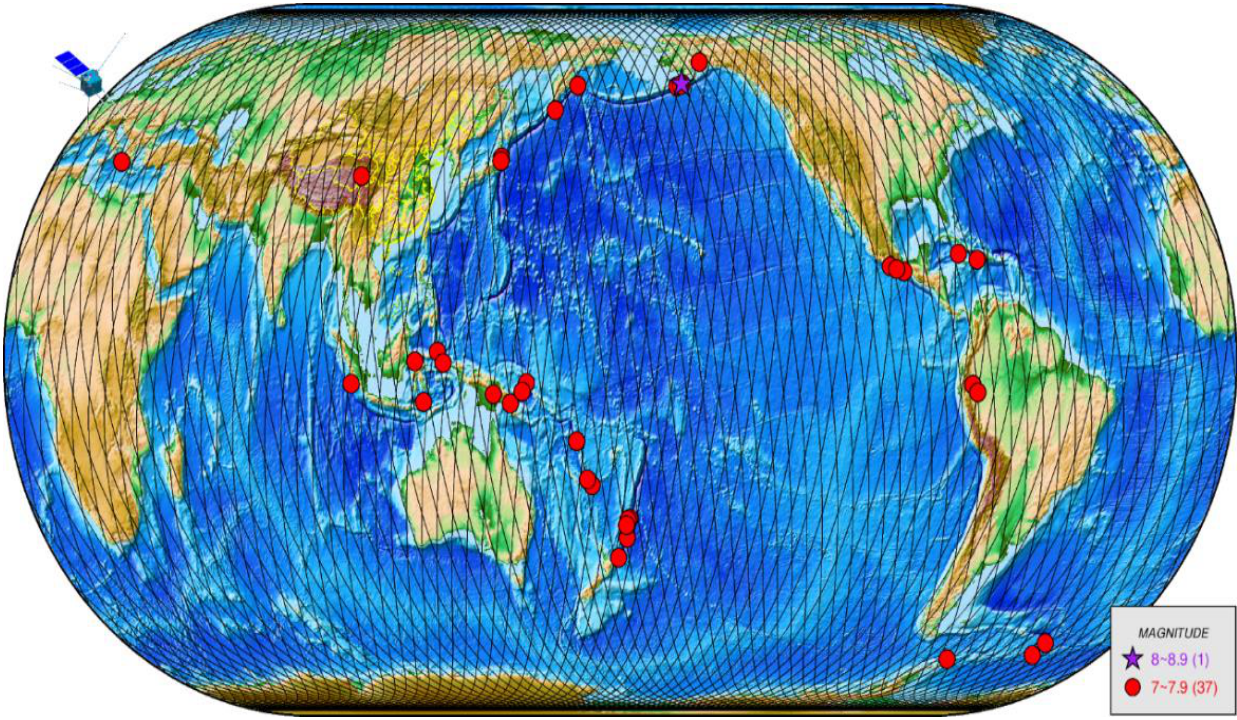
Figure 1. The global earthquake activity occurred after the launch of CSES in February 2018 to 1 December 2021. The overlapping black lines are the orbit trajectories of the CSES. Table 2. The possible seismo-ionospheric disturbances recorded by the CSES during the shallow strong EQs.